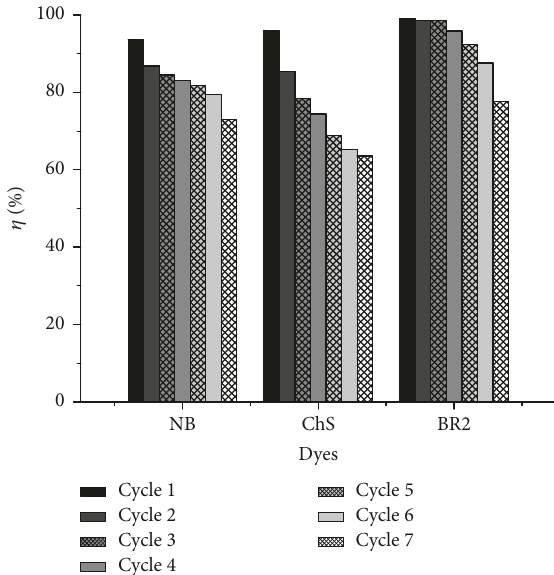
Figure 9: Removal efficiency of PM-4 in seven adsorption-desorption cycles. Table 7: Thermodynamic parameters for the adsorption of investigated dyes on PM-4 nanocomposites. Temp. Dye